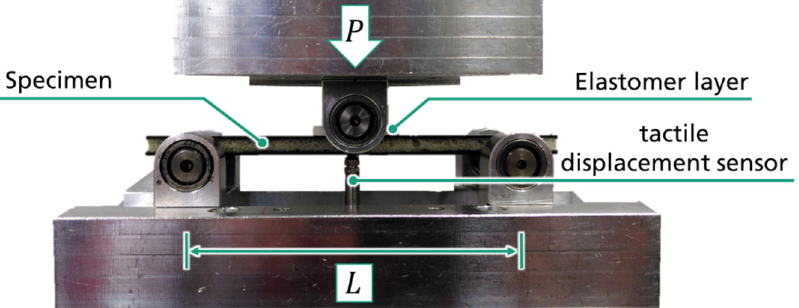
Figure 3. Three-point bending setup for sandwich characterization. A 2.5 kN load cell records the test force required to deflect the specimen. The corre- sponding specimen deflection was recorded via a tactile displacement sensor centered underneath the specimen. To prevent settling effects, a preload of 10 N was applied before